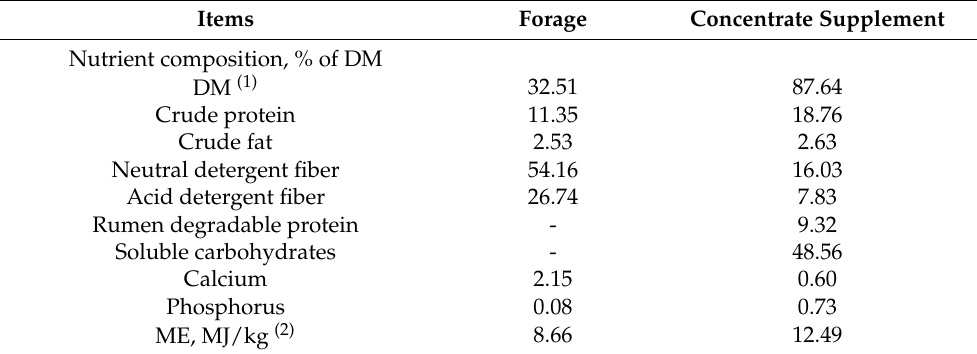
Table 1. Nutrient level of the forage and concentrate supplement